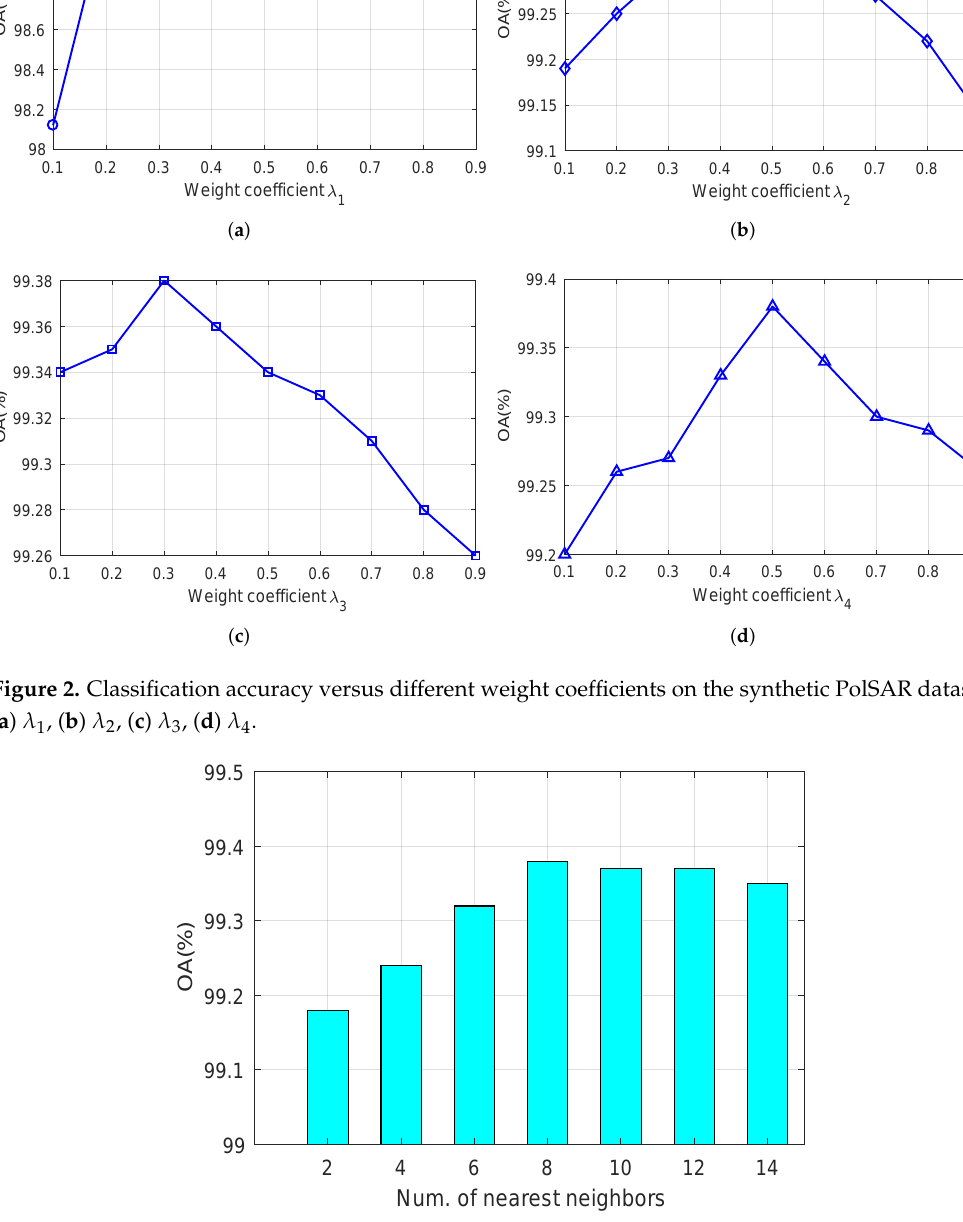
Figure 3. The overall accuracy varies with the number of nearest neighbors on the synthetic PolSAR data